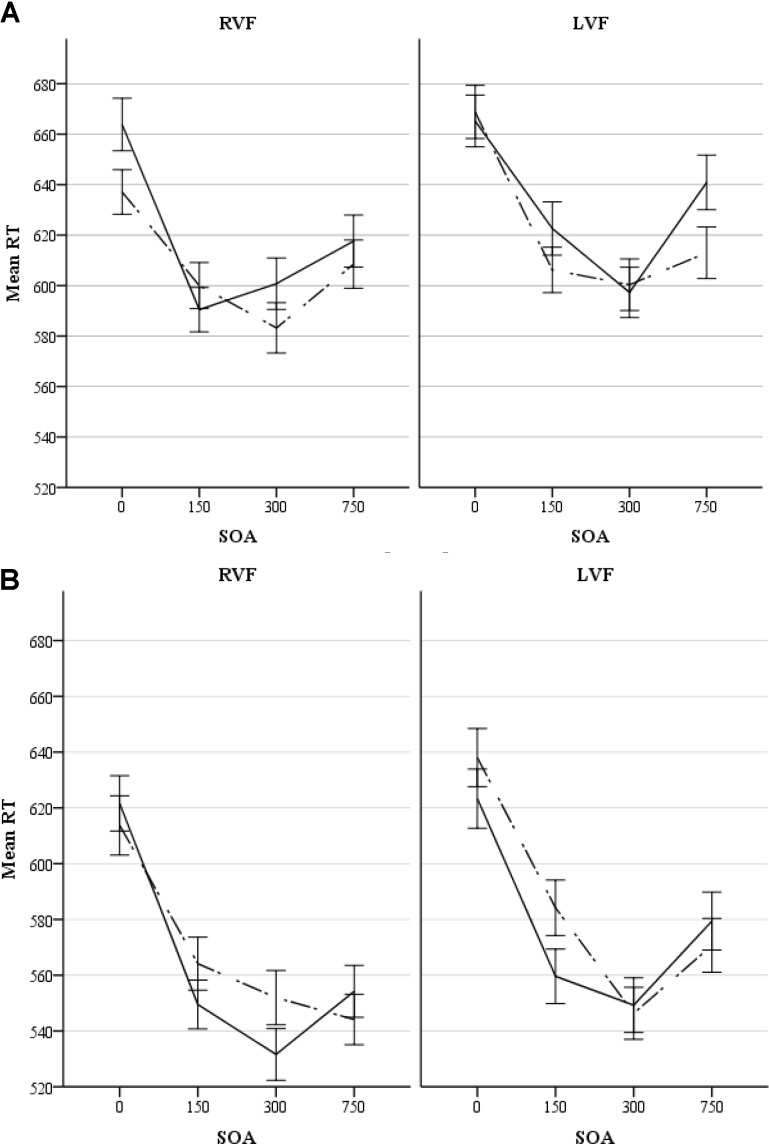
(A) Response times (ms) to congruent and incongruent pairs in each visual field as a function of SOA in male participants. The solid line and the dotted line represent congruent and incongruent pairs, respectively. Errors bars represent standard errors. (B) Response times (ms) to congruent and incongruent pairs in each visual field as a function of SOA in female participants. The solid line and the dotted line represent congruent and incongruent pairs, respectively. Errors bars represent standard errors.